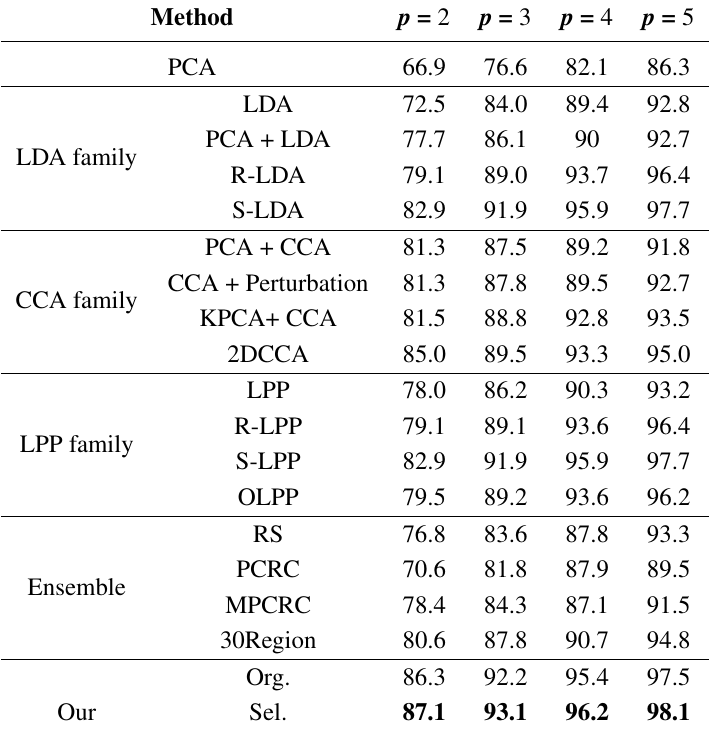
Table 1. Evaluation of the ORL database. MPCRC, multi-scale patch-based collaborative representation. LLP, locality preserving projections; CCA, canonical correlation analysis.